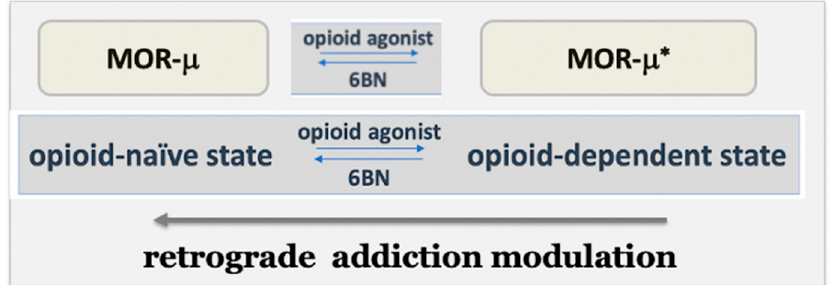
Figure 4. Hypothesis: Accelerating reversal of elevated ligand-free MOR- μ * activity to the resting MOR- μ state, 6BN gradually reverses the opioid-dependent state, directly binding to MOR- μ * without competing with opioid agonists that have low affinity to MOR- μ *. The following term is suggested for this action of 6BN: ‘retrograde addiction modulation’.